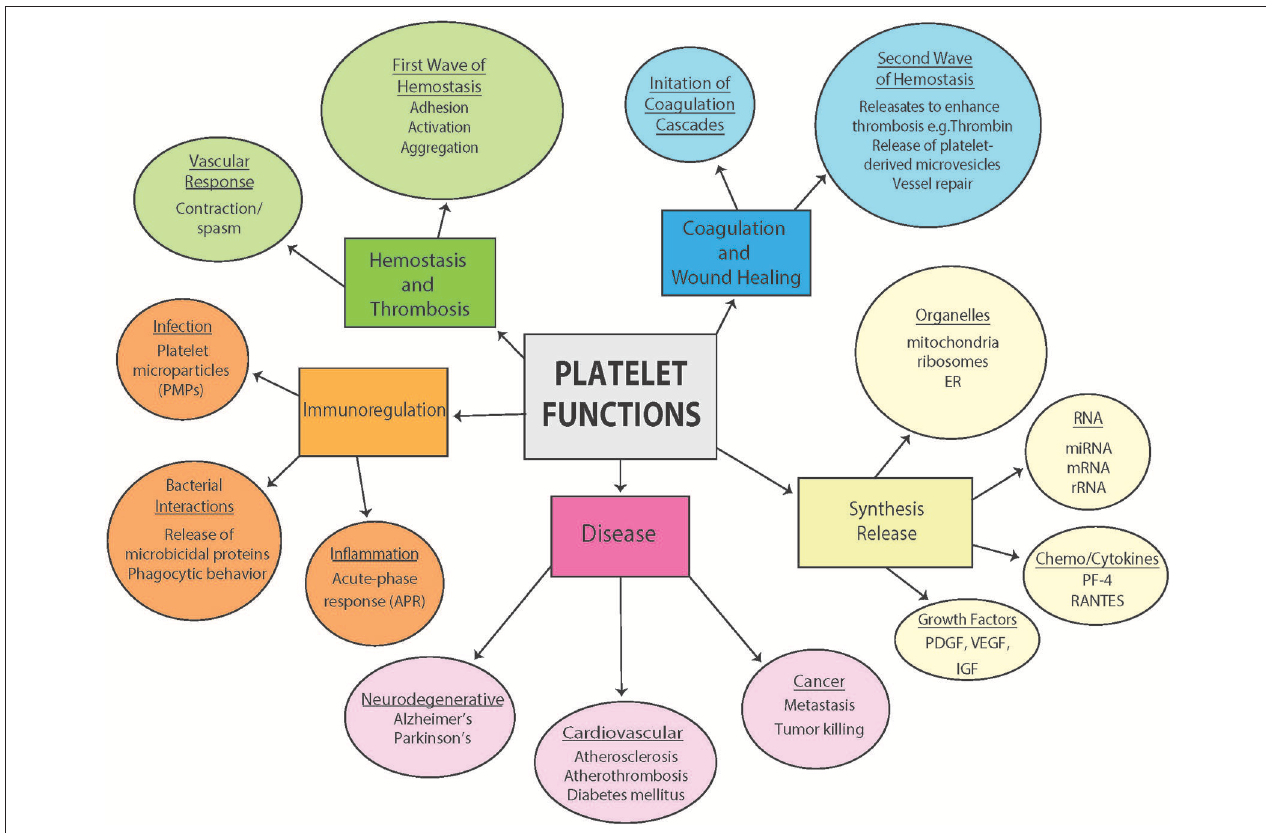
FIGURE 1 | Diversity of platelet function. Highlighted are some of the diverse pathophysiological functions of platelets both in health and disease from hemostasis and thrombosis to contributions to disease. Included are also a section outlining diverse synthesis and release of platelets and important involvement in